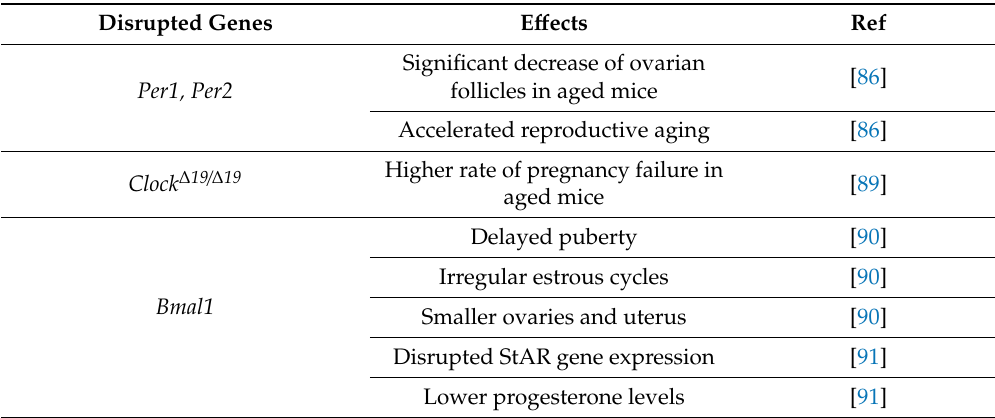
Table 2. E ff ect of disrupted genes in female mice mutant